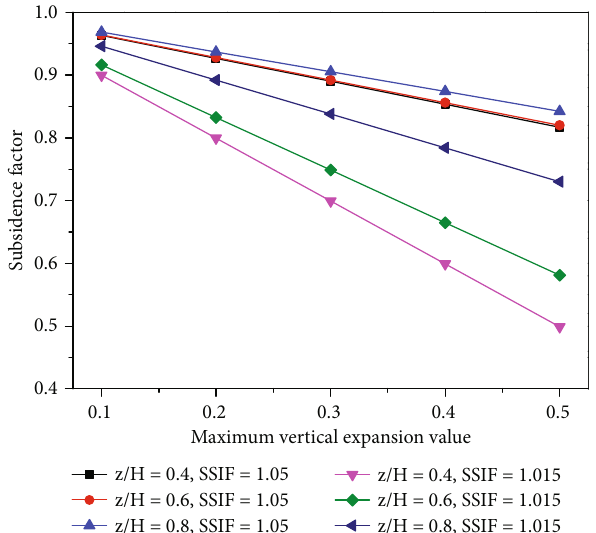
Figure 5: Relation between the subsurface subsidence factor and maximal vertical expansion